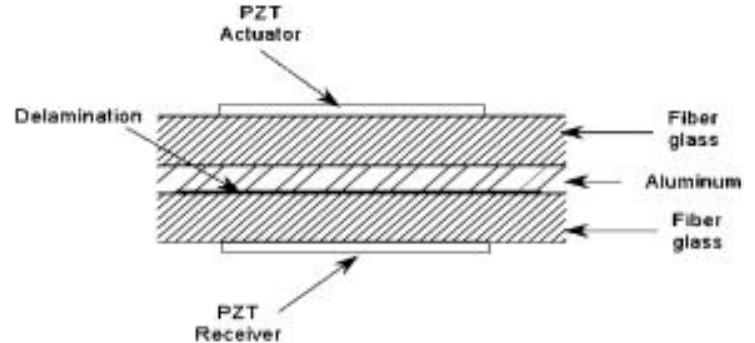
Fig. 16. Cross-section view of the flexbeam construction.